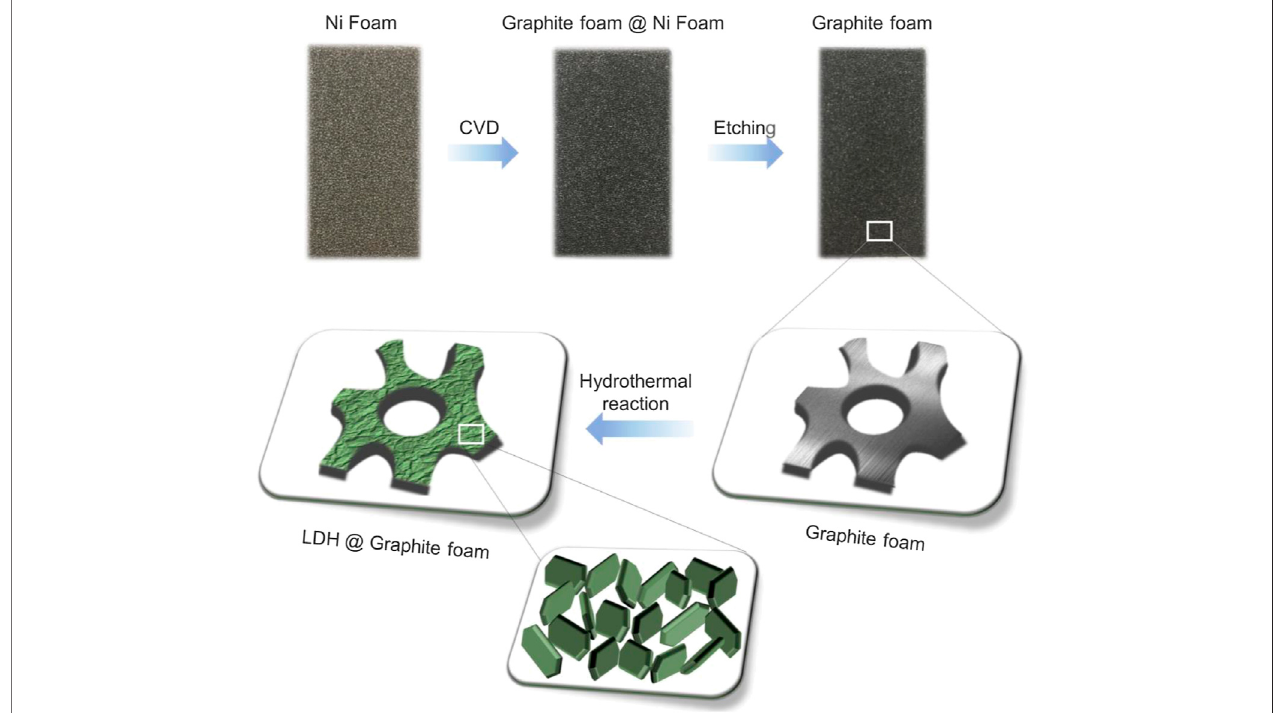
FIGURE 1 | Schematic illustration for the synthesis of NiFeRu-LDH@GF cathode.